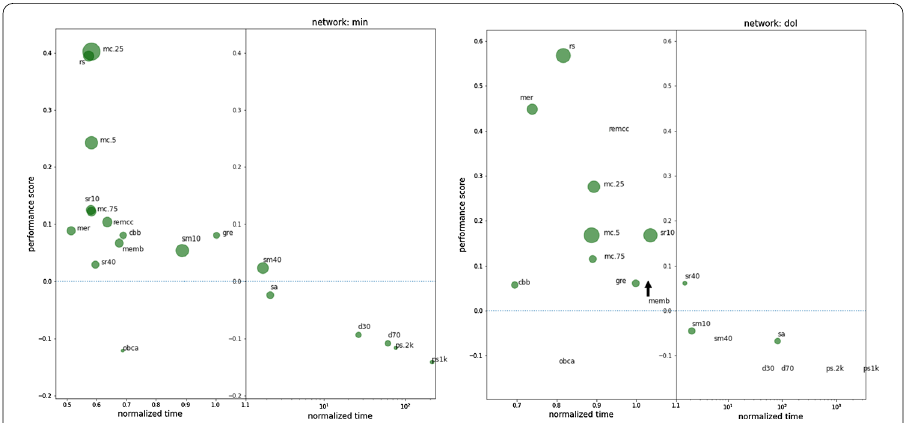
Fig. 6 Plot showing the mean P performance scores against the mean normalized runtime on the Minnesota road network and dolphins social network. The size of markers are proportional to the the variance of the performance score. Behold that the right side of the plots has logarithmic scale for the running